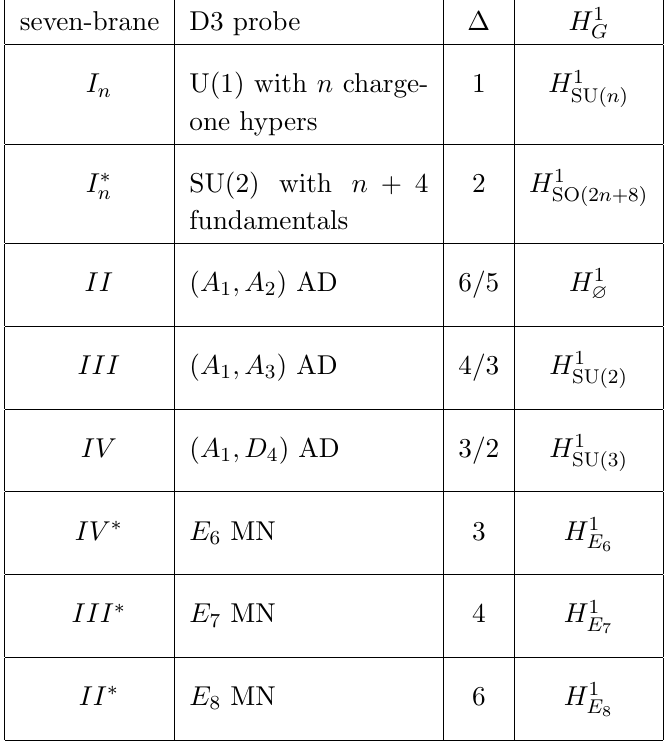
Table 7. Rank-one 4d N = 2 theories of D3-brane probes of F-theory seven-branes. Each entry of this table must be supplemented with a free center of mass